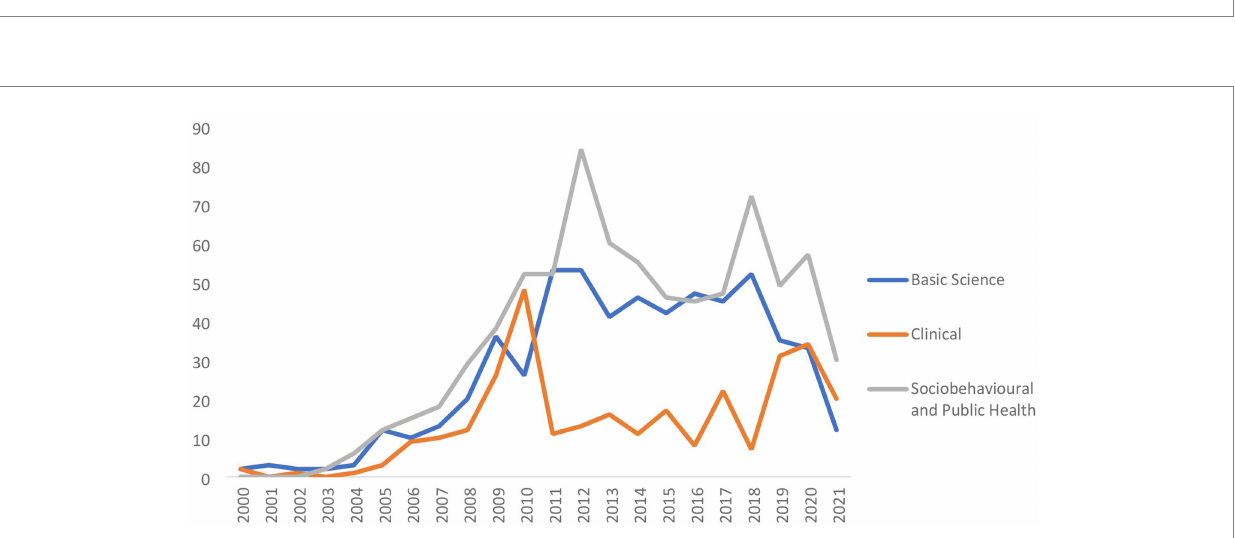
FIGURE 3 Trend of number of publications included in the review based on type of